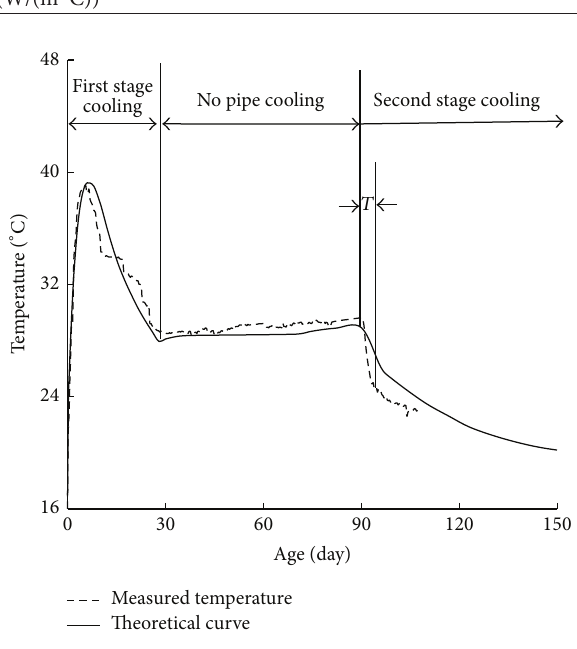
Figure 3: Water cooling